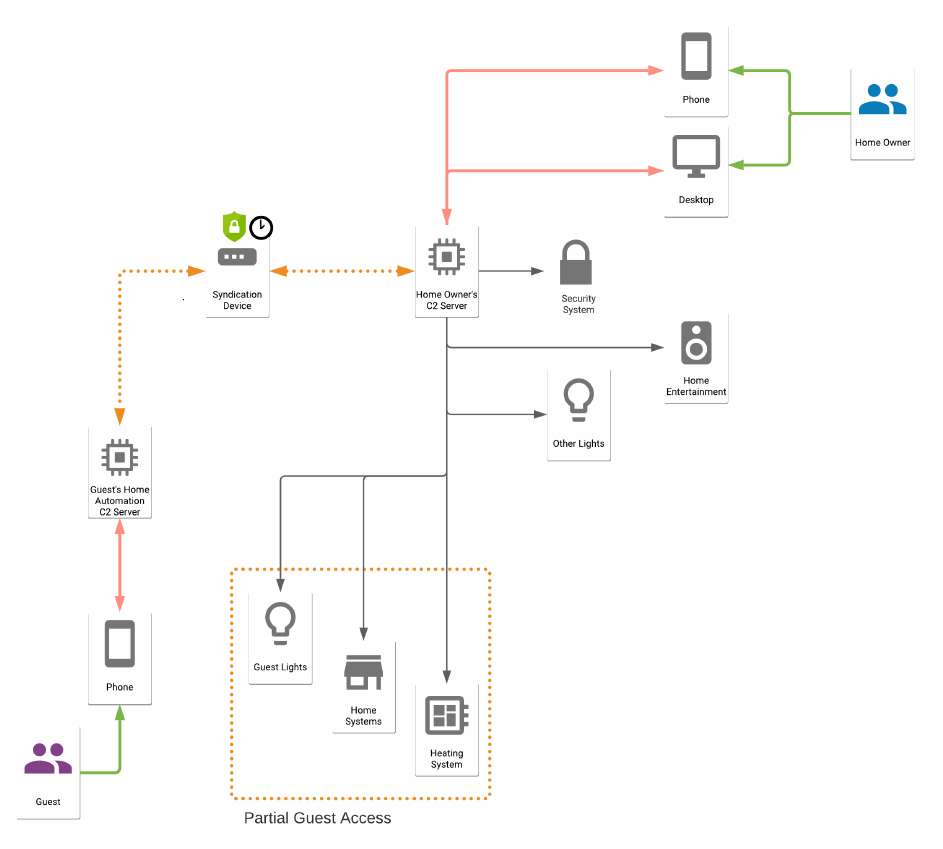
Figure 8. An illustration of the integration of guest access to a C2 system, utilizing syndication to provide moderated access to parts of the